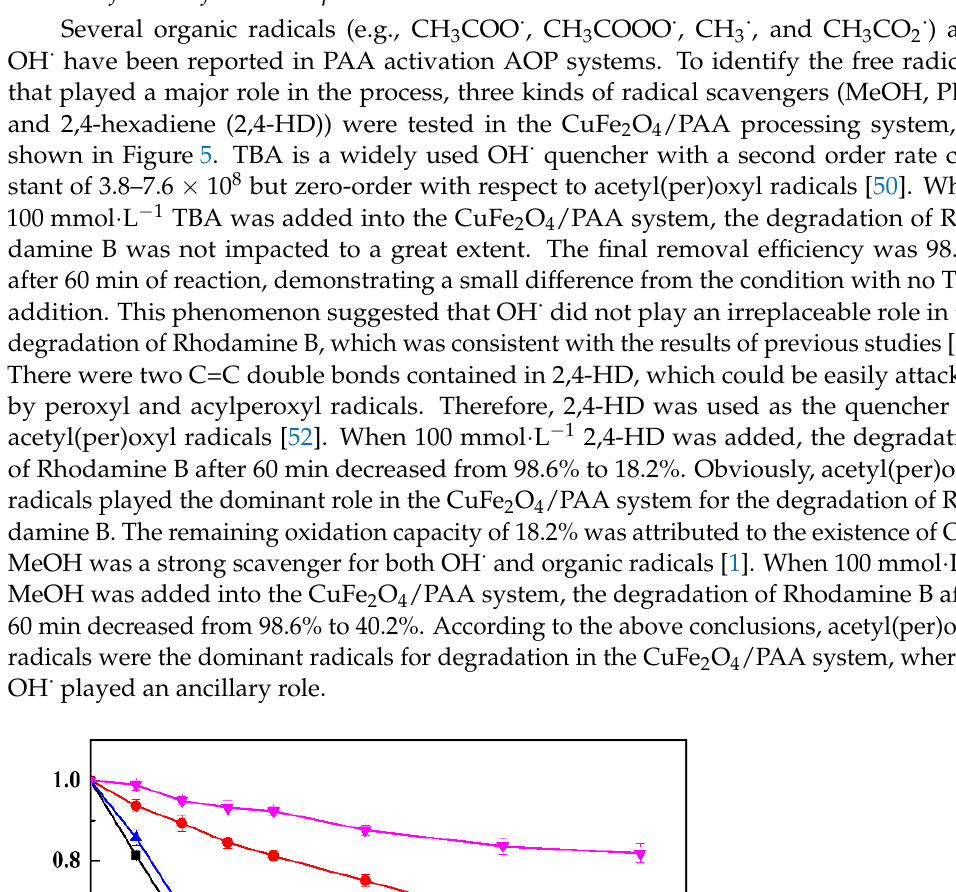
Figure 6. The proposed mechanism of the CuFe 2 O 4 /PAA system.